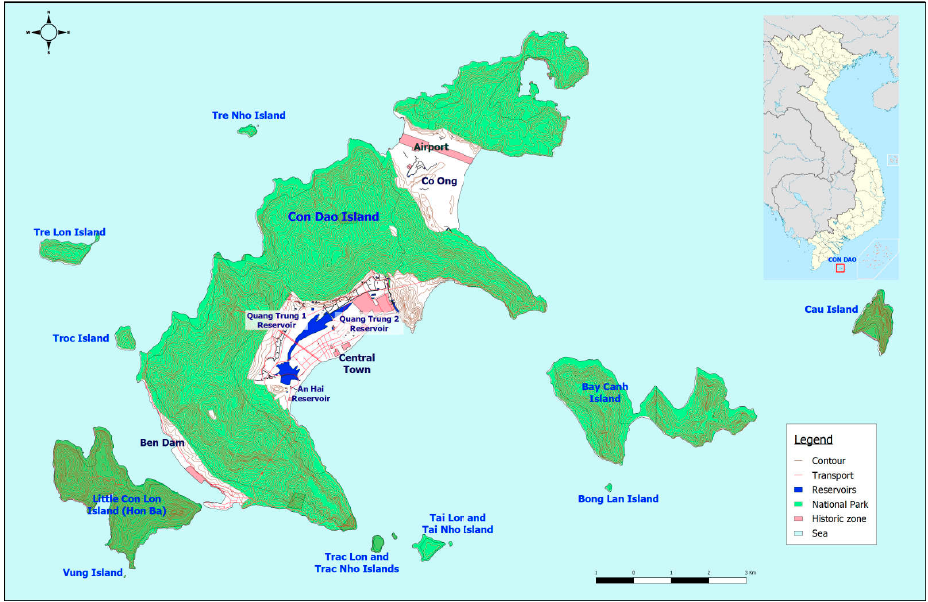
Figure 2. Map of Con Dao Islands (Modified from